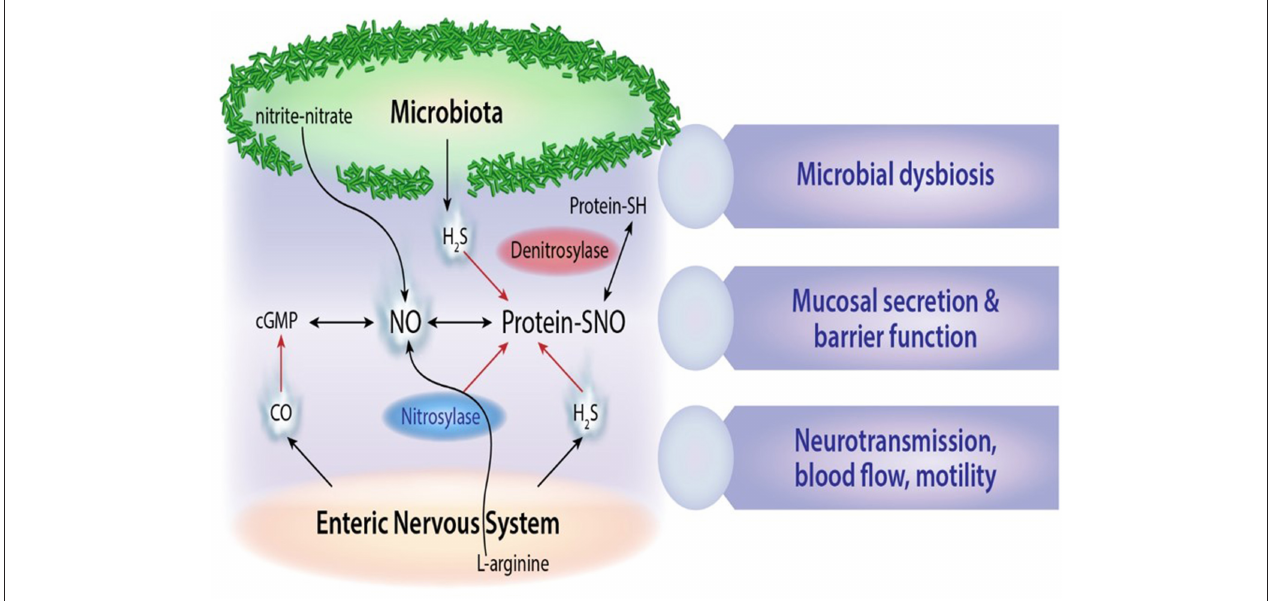
FIGURE 2 | Microbial gaseous neurotransmitters. Schematic outline of microbial derived nitric oxide (NO), S-nitrosothiol derivatives (SNO), and hydrogen sulfide (H 2 S) signals and their cross-interactions with carbon monoxide (CO) neurotransmitters in the enteric nervous